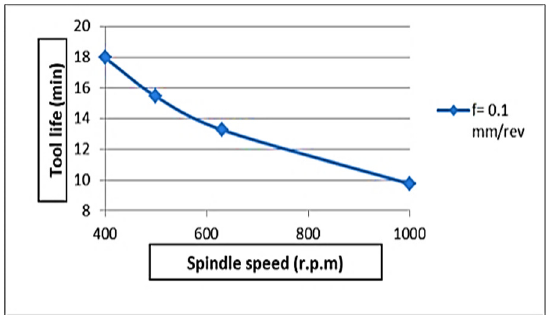
Fig. 14. Temperature fields of machining with spindle speed (400 r.p.m), feed (0.10 mm/rev), depth. (0.5m), temperature distribution simulation, experimental measuring of temperature using IR-Camera.